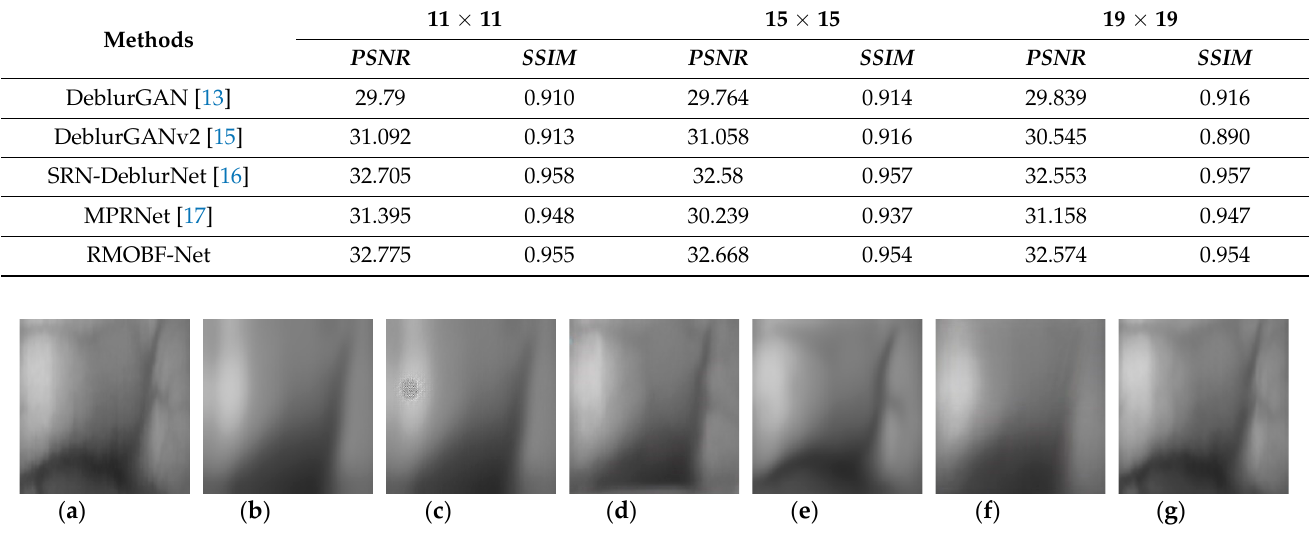
Figure 12. Examples of restored SDU-DB finger-vein images using the state-of-the-art methods and the proposed RMOBF-Net (motion blur with Gaussian blur filter of 11 × 11): ( a ) original image, ( b ) blurred image and images restored by ( c ) DeblurGAN, ( d ) DeblurGANv2, ( e ) SRN-DeblurNet, ( f ) MPRNet, and ( g ) RMOBF-Net.